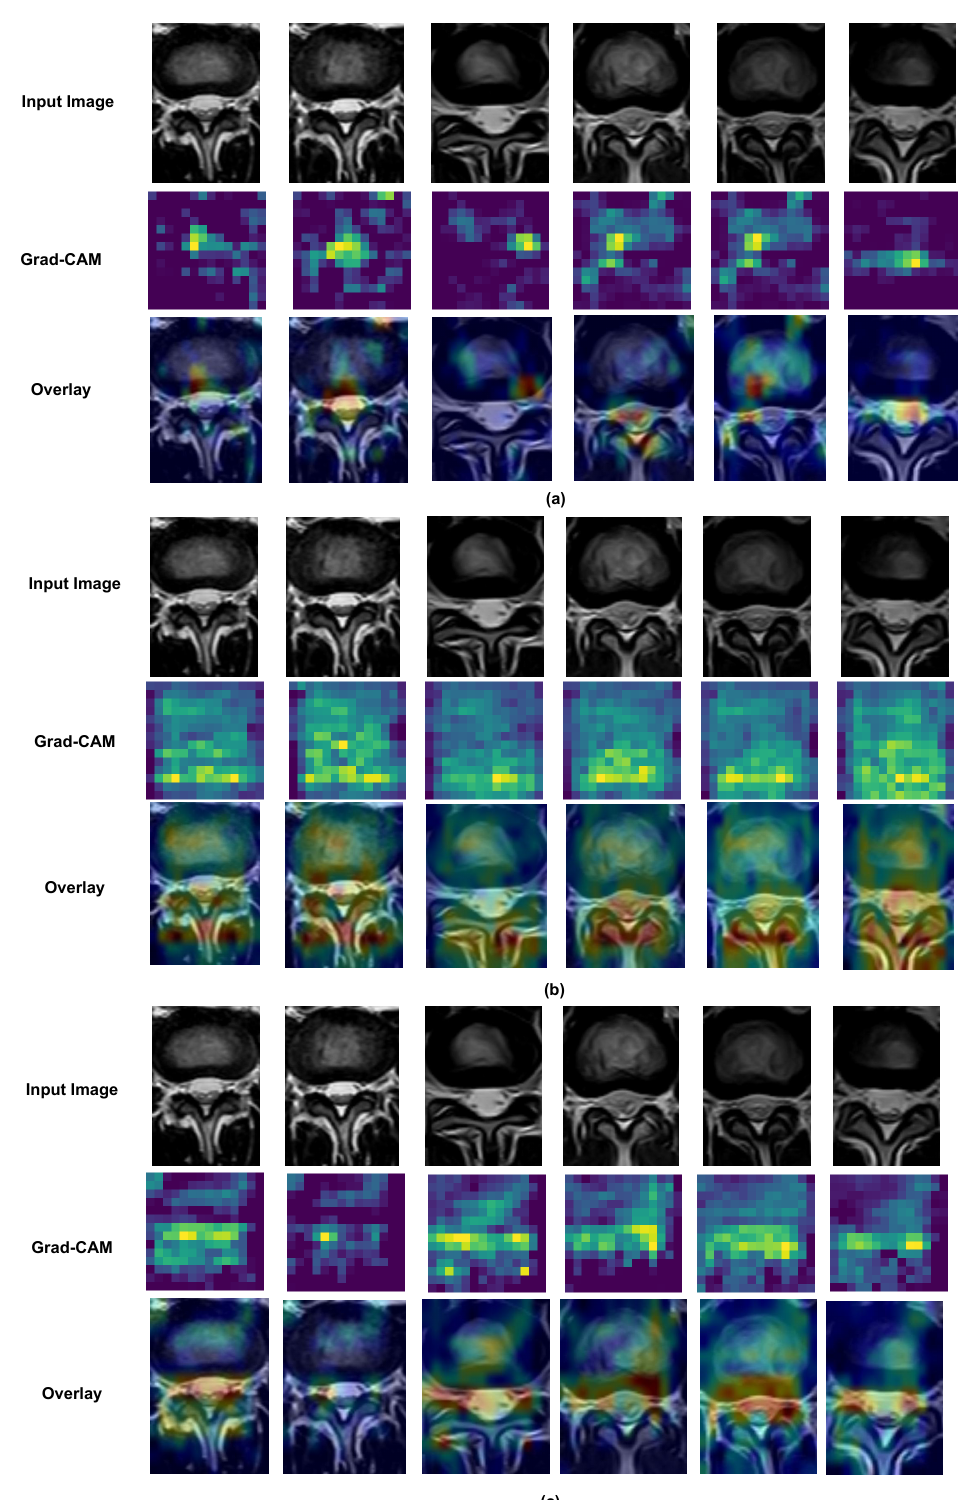
Figure 17. Grad-CAM visualization of features using VGG16 for disc state classification TL from ( a ) ImageNet, ( b ) labeled data (Dataset A), ( c ) unlabeled data (Dataset